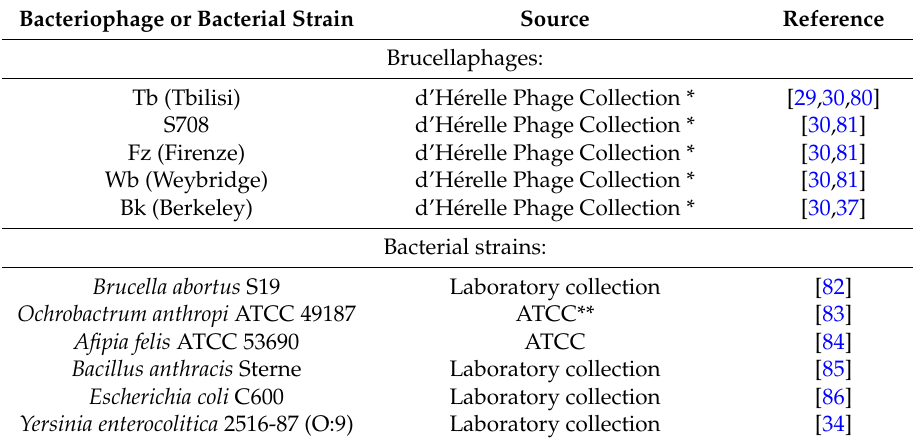
Table 2. Bacteriophages and bacterial strains used in this work. Bacteriophage or Bacterial